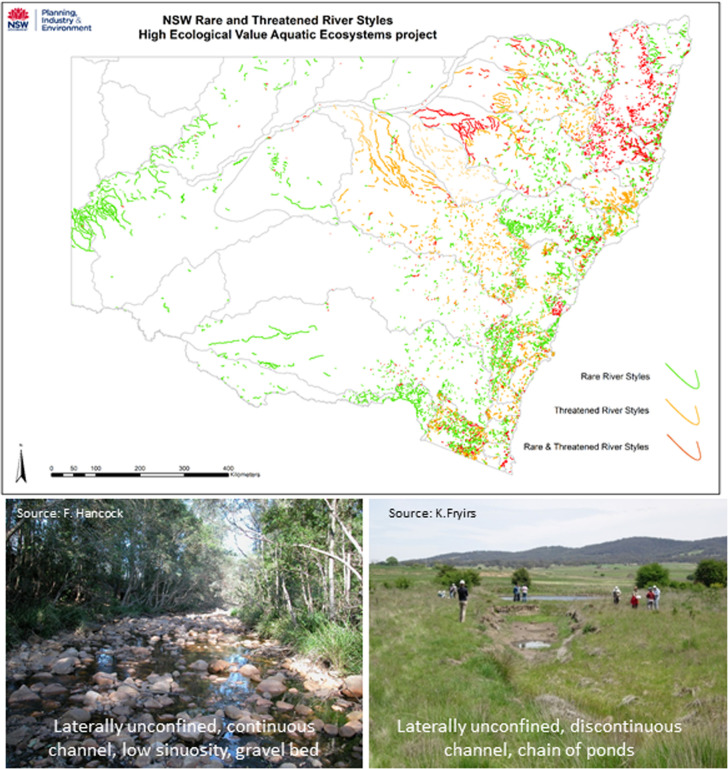
Rarity and threatened River Styles in NSW.Source of photos as noted.